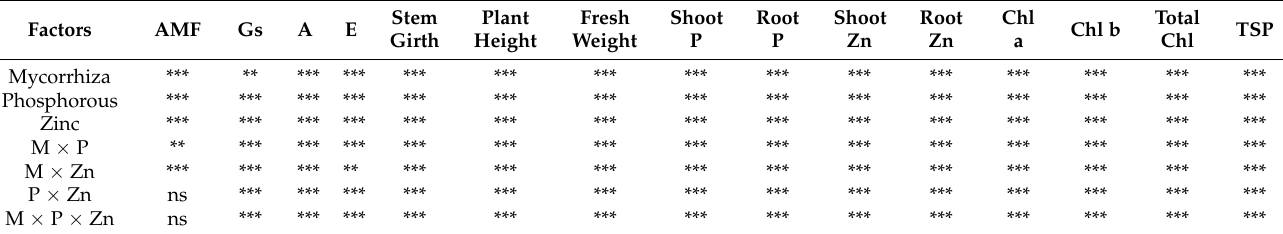
Figure 1. Arbuscular mycorrhizal fungi (AMF) root colonization percentage at harvest of AM maize plants grown under various P (0–full recommended dose) and Zn (0–120 mg Zn/kg soil) application rates. Mean values are presented with ± standard error (SE). Different letters on the bars indicate significant differences at p ≤ 0.05. P1 = 14.5 kg, P2 = 29 kg, P3 = 58 kg; Zn control = 0, Zn1 = 20, Table 2. ANOVA summary of various measured parameters.